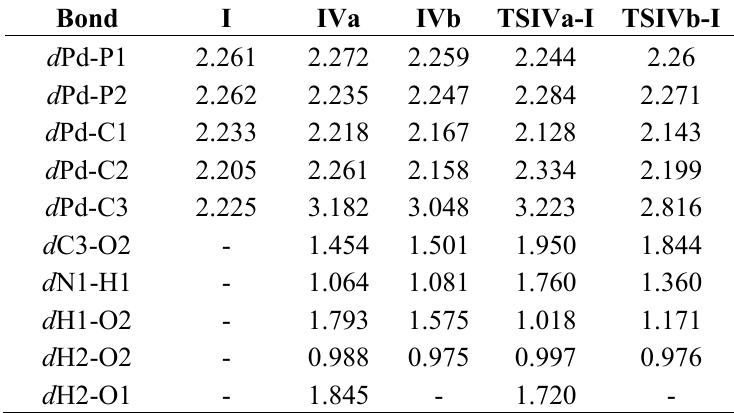
Table 2. Bond lengths (Å) of the calculated structures of intermediates involved in oxidative addition